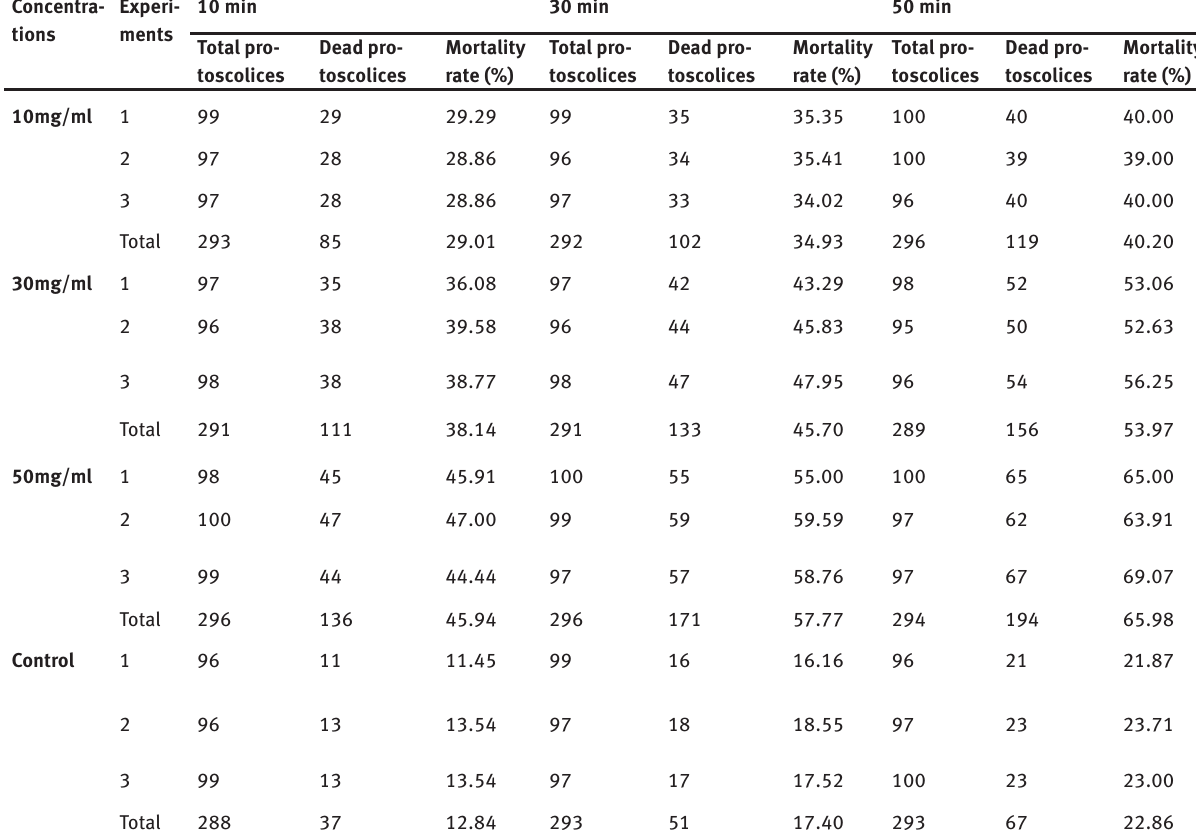
Table 2: Antiprotoscolices effect of B.wallichiana extracts at different concentrations and exposure times. Concentra-